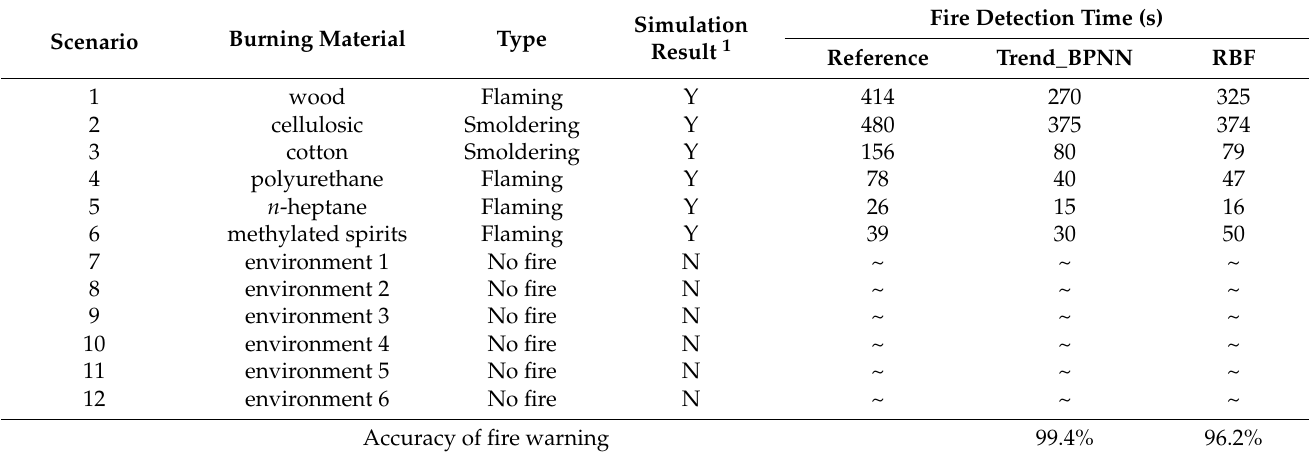
Table 4. The simulation results of 12 experimental